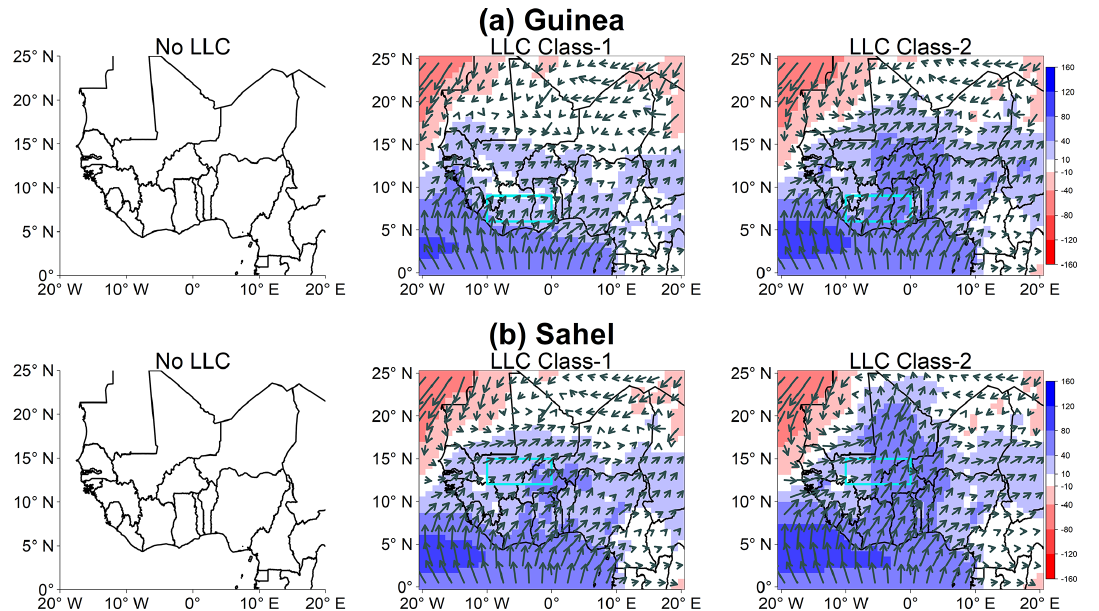
Figure 5. Composites of 950hPa moisture flux (colors, gkg − 1 ms − 1 ) and wind (vectors, ms − 1 ) over WA for the three LLC occurrence classes in the Guinea (a) and Sahel (b) windows during JAS from 2006 to 2015. Only occurrences that last for at least 6 consecutive hours are considered. Wind vectors are averaged over two grid points in both the x and y directions. No event of the No LLC class has been extracted in the Guinea and Sahel regions during JAS, hence the empty plots.